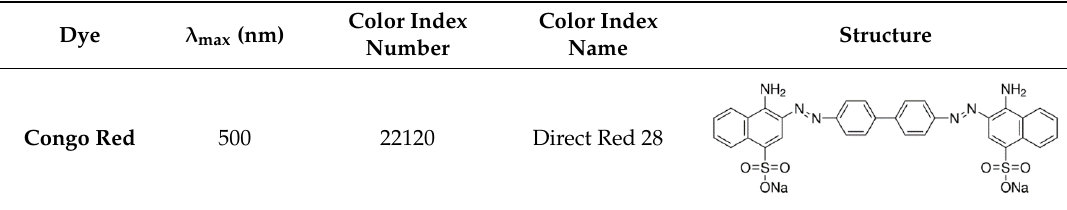
Table 1. Congo Red dye main